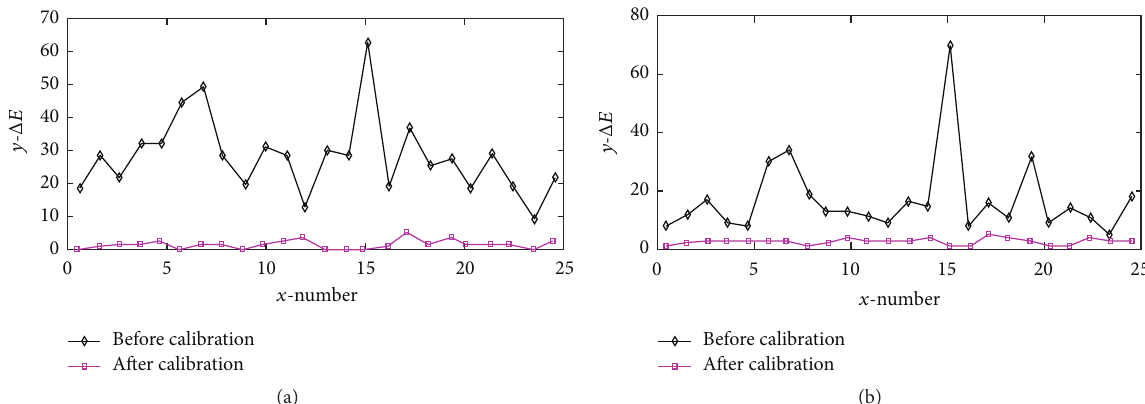
Figure 5: The comparison of color difference of color patches. (a) Mapping Φ RGB → sRGB ( LED ) under the LED illuminator and (b) mapping ( ad 65) under the artificial D65 illuminator. Φ RGB → sRGB